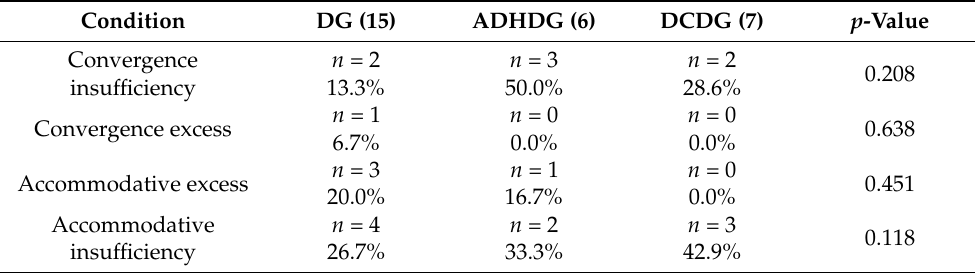
Figure 3. Mean values for the measurement with the cover test of the distance and near phoria in the subgroups of dyslexia (DG), attention deficit/hyperactivity disorder (ADHDG) and developmental coordination disorder (DCDG). Table 8. Distribution of the different accommodative and binocular anomalies diagnosed in the three subgroups of children with neurodevelopmental disorders evaluated: DG, dyslexia group; ADHDG, group of children with attention deficit/hyperactivity disorder; DCDG, group of children with developmental coordination